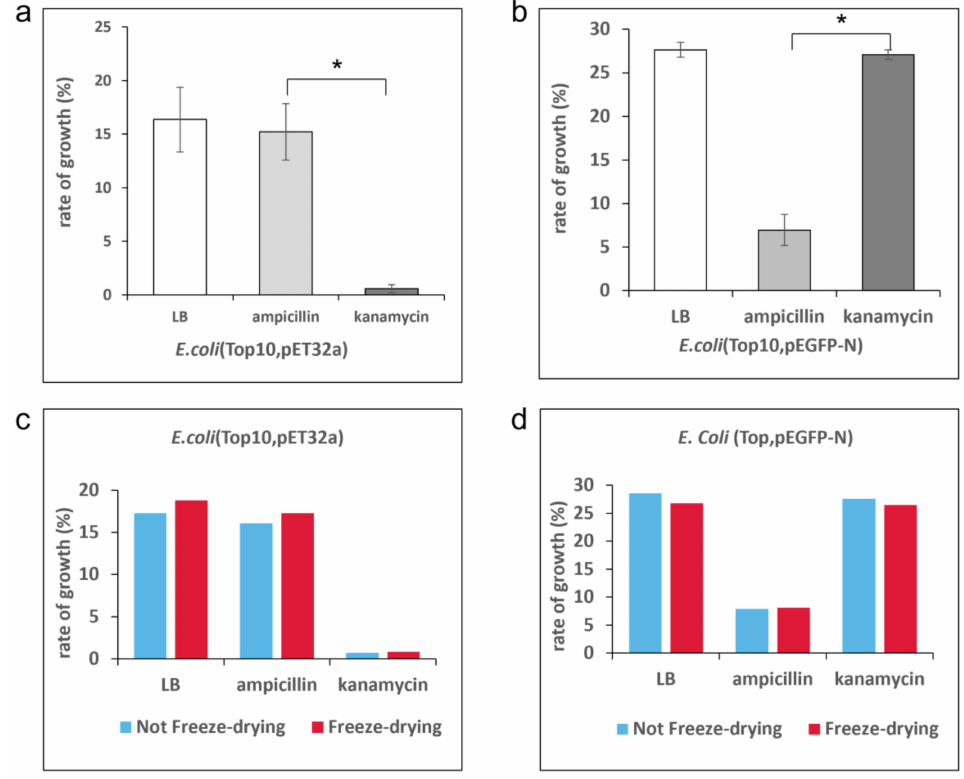
Figure 6. The validation test with E. coli in the single-cell level rapid AST system. ( a ) Growth rates of E. coli (Top10, pET32a) in the presence of Ampicillin and Kanamycin. E. coli (Top10, pET32a) shows high sensitivity to Kanamycin and high resistance to Ampicillin. ( b ) Growth rate of E. coli (Top10, pEGFP-N) in the presence of Ampicillin and Kanamycin. E. coli (Top10, pET32a) shows high sensitivity to Ampicillin and high resistance to Kanamycin. LB is the blank control group of antibiotic-free medium. ( c ) Consistent results for the absence and presence of drug prepositioning for E. coli (Top10, pET32a) in the presence of Ampicillin and Kanamycin. ( d ) Consistent results of the absence or presence of drug prepositioning for E. coli (Top10, pEGFP-N) in the presence of Ampicillin and Kanamycin. (* p <